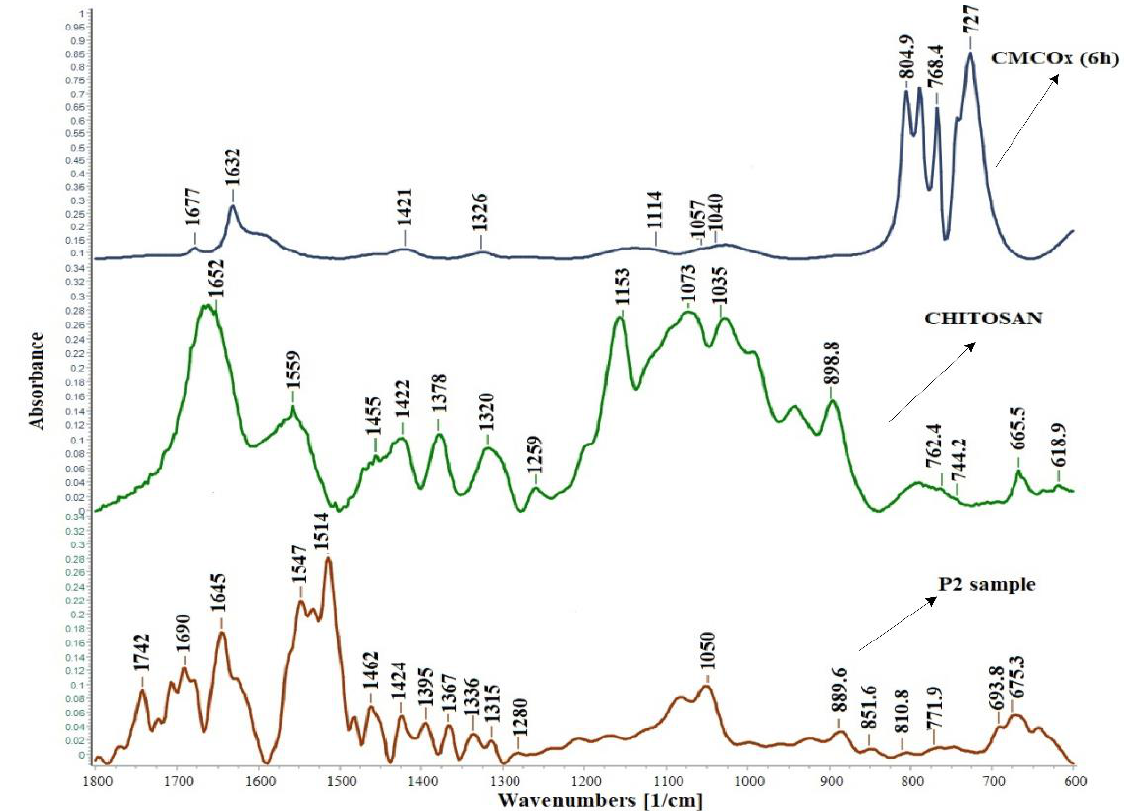
Figure 6. FTIR spectra of CS, CMCOx, and P2 films (with a molar ratio NH 2 /CHO = 1:0.375 mol/mol).